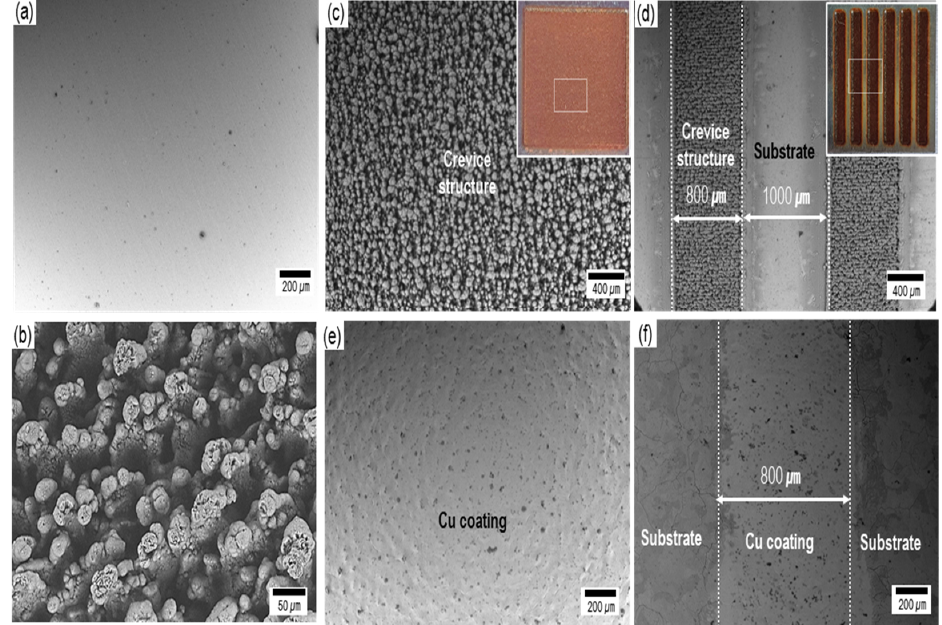
Figure 2. SEM images before( a – d ) and after( e – f ) copper coating. ( a ) as-received carbon steel sub- strate. ( b ) fine crevice structure by laser irradiation. Uncoated ( c ) all and ( d ) 48% of the substrate. Coated ( e ) all ( f ) 48% of the substrate.